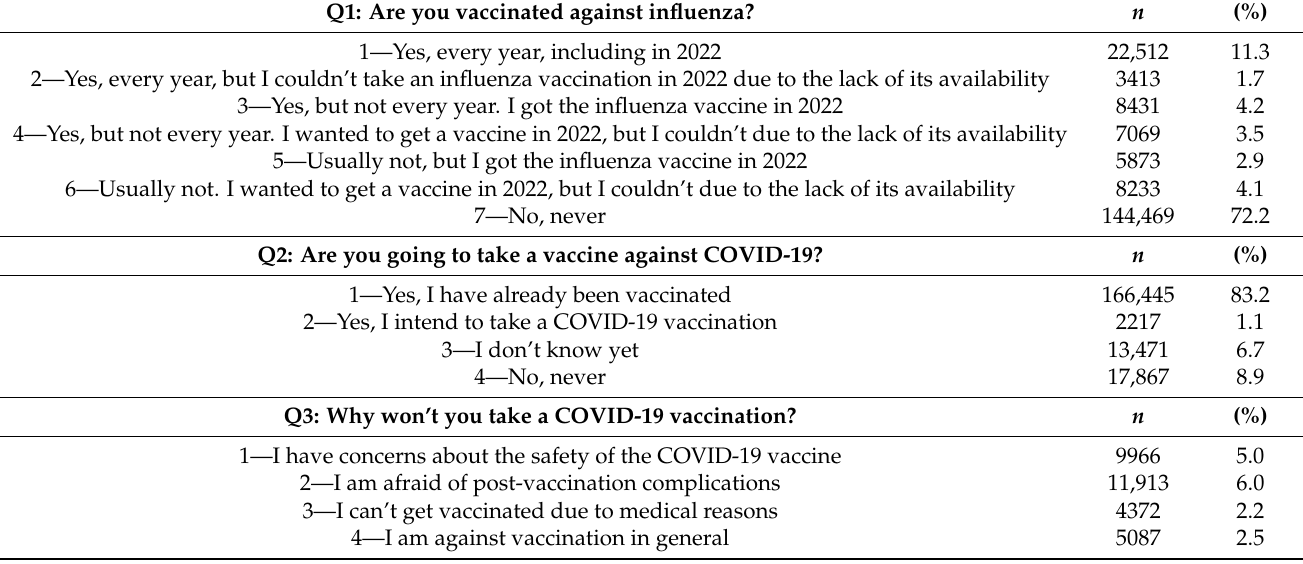
Table 2. Number (percentage) of respondents in groups differing in their assessment of approach to vaccination among 200,000 participating in the